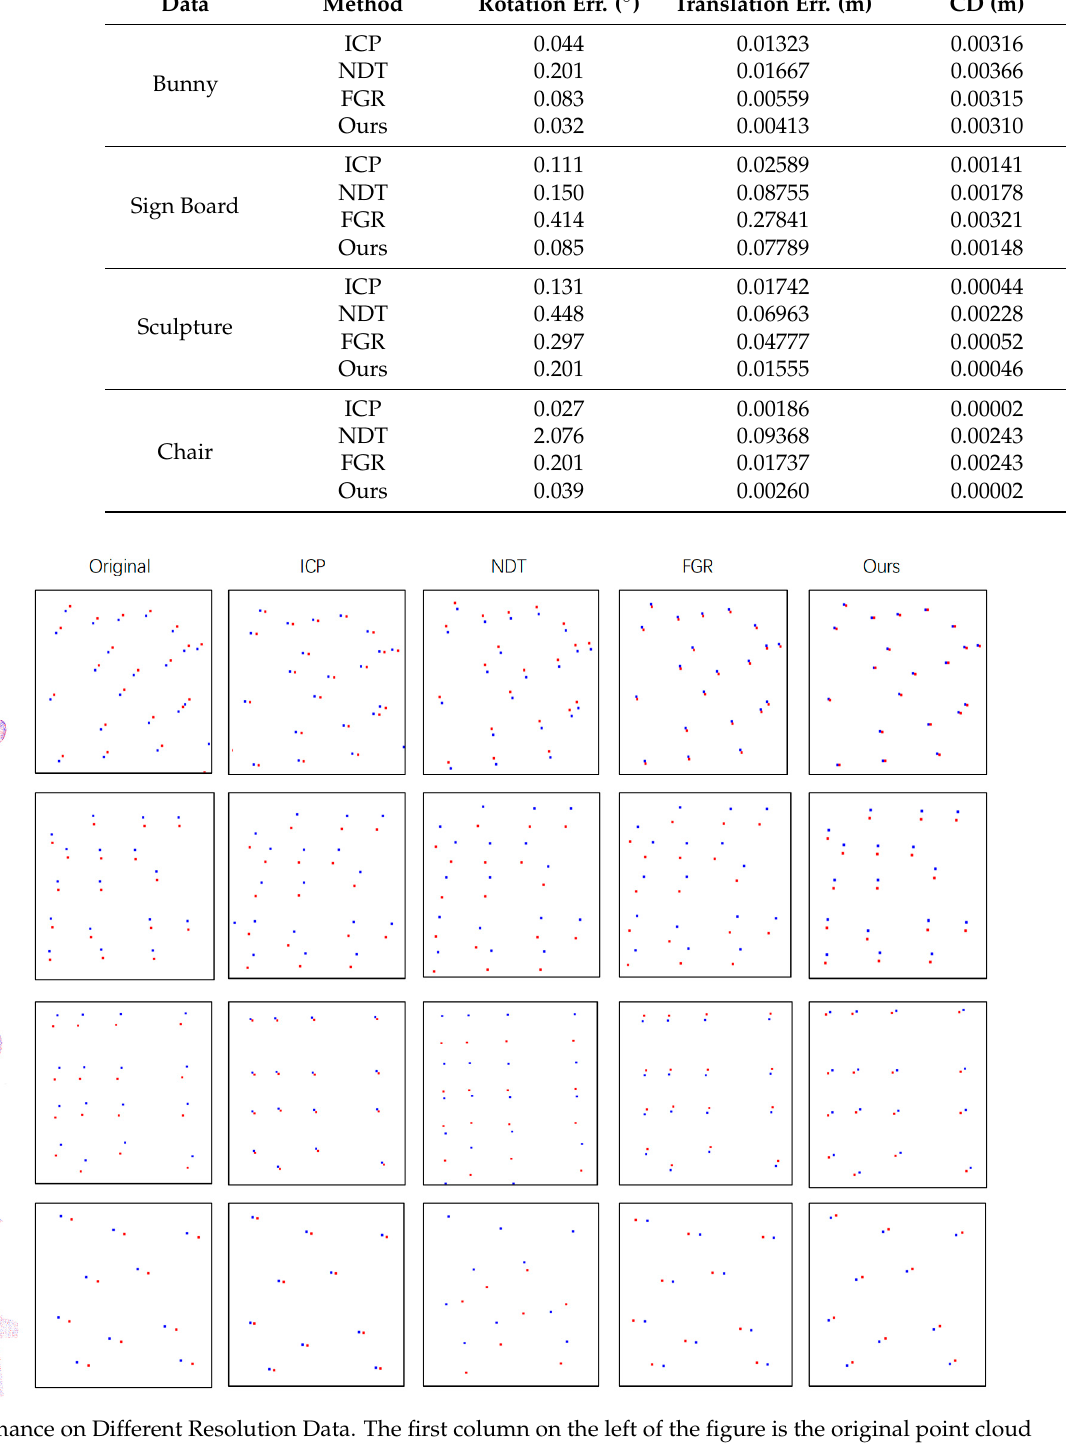
Figure 9. Performance on Different Resolution Data. The first column on the left of the figure is the original point cloud data, the second column is the detailed schematic diagram and the rest are the detailed diagrams after registration by each method. Table 3. Performance on Gaussian Noise Data.